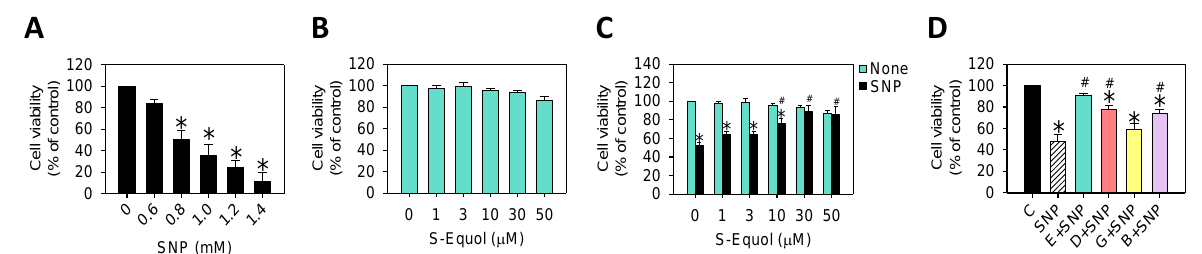
Figure 1. Effects of SNP and/or isoflavones on the viability of primary chondrocytes. ( A ) The cells were treated with 0.6–1.4 mM SNP for 24 h; ( B ) The cells were treated with 1–50 µ M S-Equol for 24 h; ( C ) The cells were treated with 1–50 µ M S-Equol for 24 h in the presence or absence of 0.8 mM SNP for another 24 h; and ( D ) The cells were treated with 30 µ M S-Equol (E), Daidzein (D), Genistein (G), or Biochanin A (B) for 24 h in the absence (control) or presence of 0.8 mM SNP for another 24 h. The results are expressed as the mean ± the S.D. for three separate experiments. * p < 0.05 compared to the untreated control group. # p < 0.05 compared to the SNP treated group.